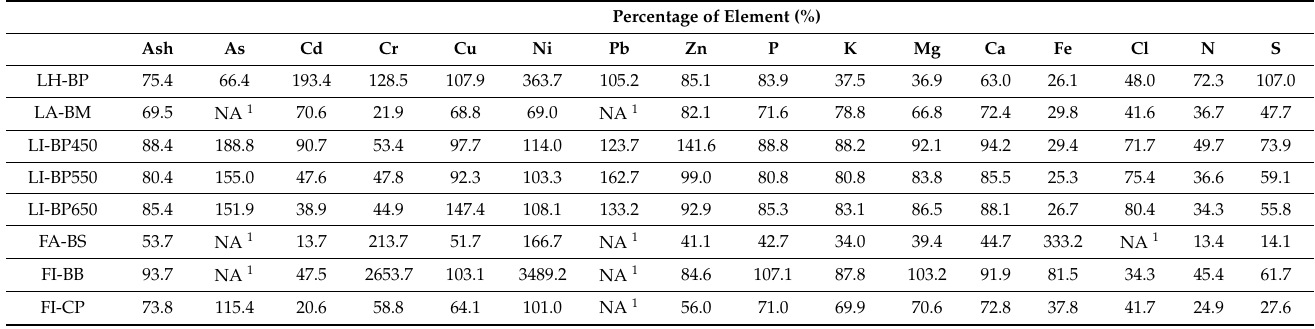
Table 5. The retention of overall ash in the produced biochar as well as that of the individual elements as a percentage (%) of the content in the grass